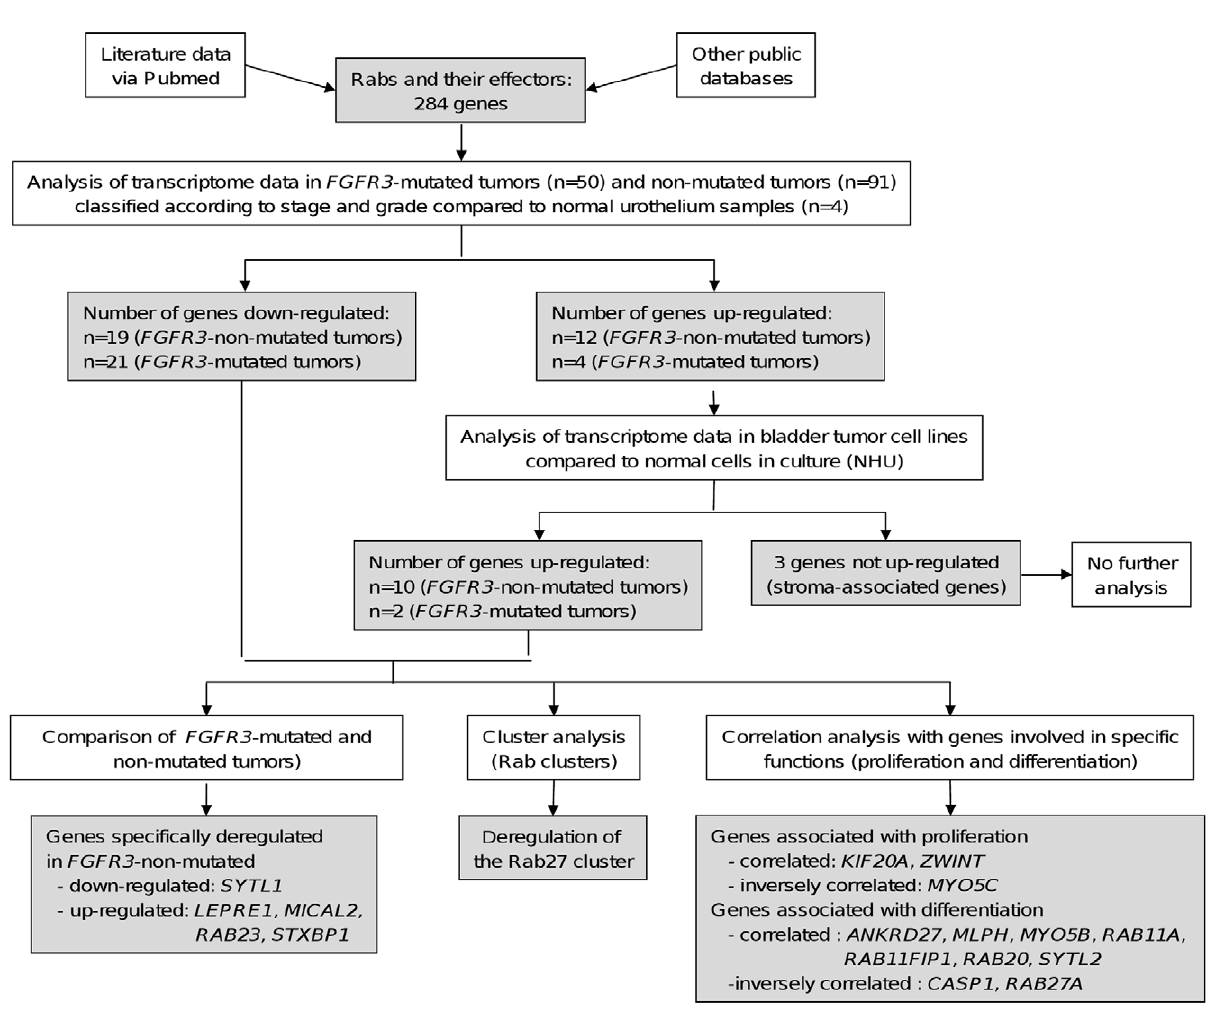
Figure 2. Results obtained after the different analysis steps. The results of each analysis step are shown in the flow chart presented in Figure 1.